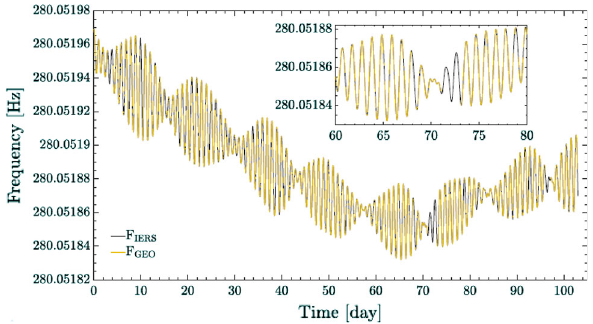
Fig. 2 Ω geo evaluated from the LR analysis applied to GINGERINO data compared with K cal · Ω IERS . The detail of 20 days is shown in the inset. The data removed from the analysis are